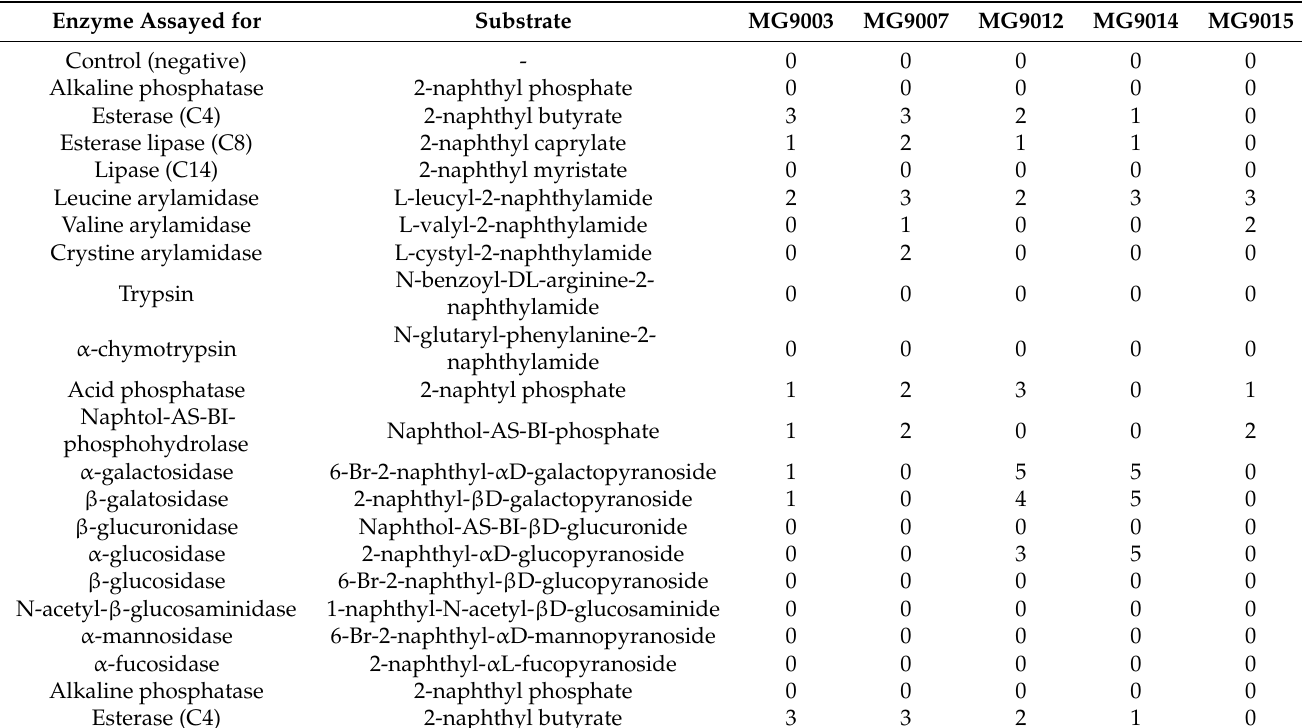
Table 3. Enzyme activities of selected strains assayed using API ZYM